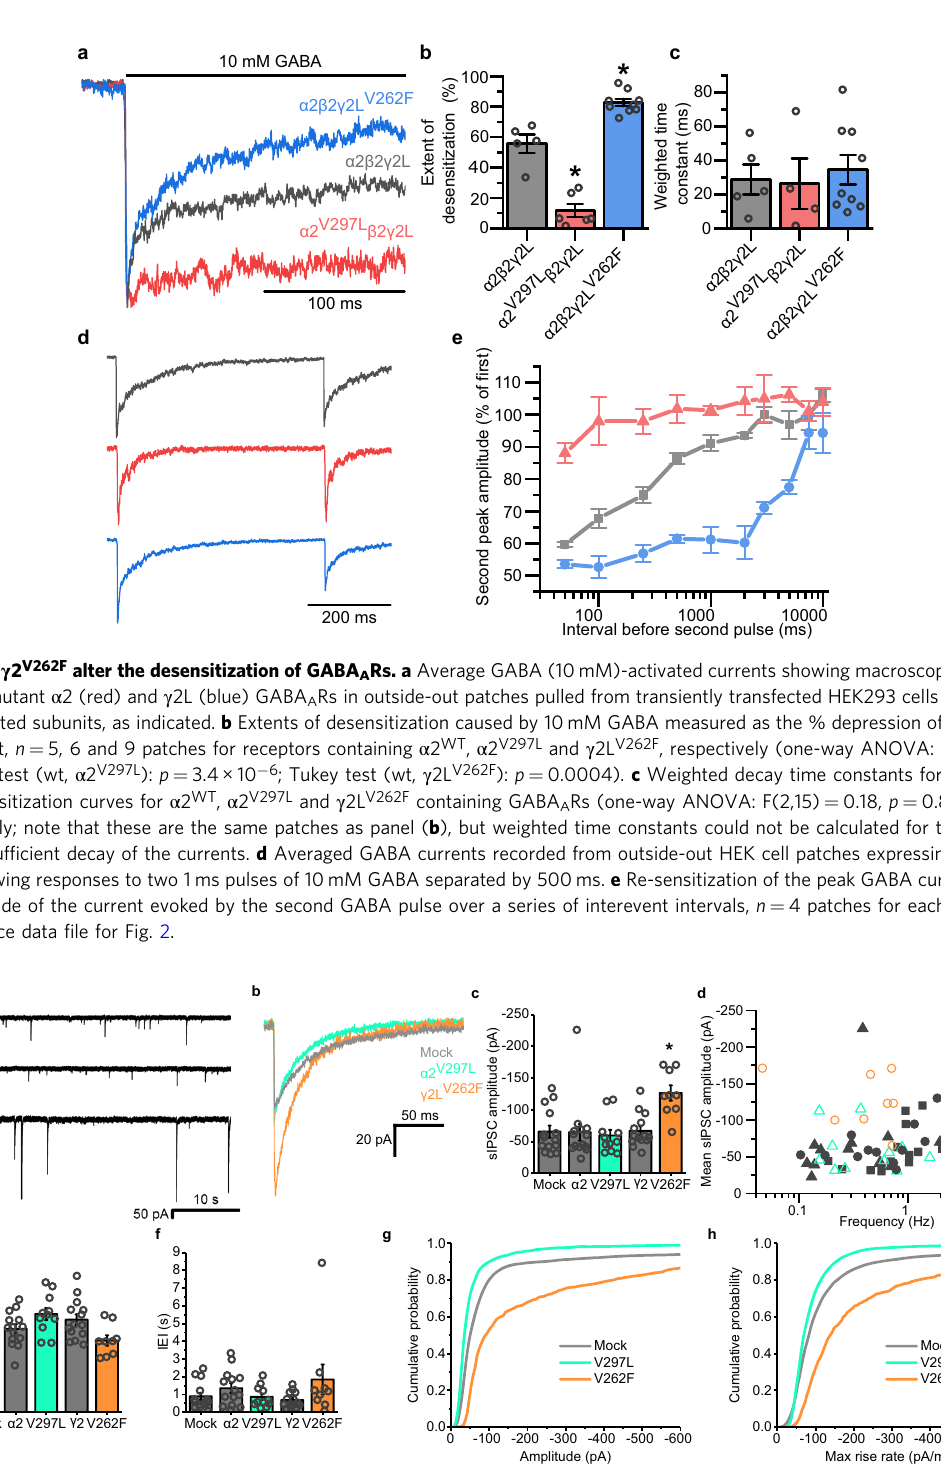
Fig. 3 γ 2 V262F expression increases sIPSC amplitudes at room temperature. a Representative sIPSC traces, recorded at 21 °C from voltage-clamped neurons expressing the indicated constructs (mock transfection, black; α 2 V297L , green; γ 2 V262F , orange). b Average waveforms of sIPSCs recorded for each receptor construct, aligned on the rising phase and not peak scaled. c Mean sIPSC amplitudes for neurons either mock-transfected, or expressing α 2 or γ 2L wild type, or α 2 V297L , γ 2L V262F (one-way ANOVA: F (4, 57) = 5.68, p = 0.00064; Tukey test (mock, α 2 V297L ): p = 0.99; Tukey test (mock, γ 2l V262F ): p = 0.0022; n = 14, 14, 11, 14 and 9 neurons, respectively). d Mean sIPSC amplitude plotted against mean sIPSC frequency for neurons transfected with the indicated constructs. e Mean 20 – 80% rise time of the synaptic events of the recorded cells (one-way ANOVA: F (4,57) = 3.24, p = 0.017; Tukey test (V297L, V262F): p = 0.013). f Median interevent intervals (IEI) for all cells (one-way ANOVA: F (4,57) = 1.72, p = 0.16). g Mean cumulative probability distributions of the amplitudes, and h maximum rate of rise for the slopes of all sIPSCs recorded; n = 4334 events from 14 cells (Mock), 3973 events from 11 cells ( α 2 V297L ) and 1596 events from 9 cells ( γ 2L V262F ). Source data are provided as a Source data fi le for Fig.